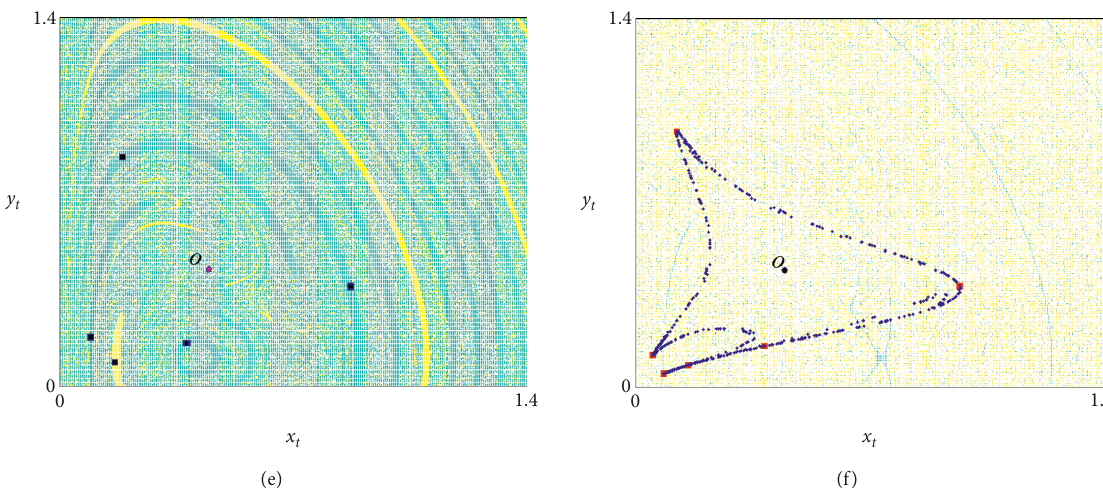
Figure 7: (a) The 2D bifurcation diagram in the ( k, c ) − plane at a � 1 showing different period cycles with different colors. (b) Bifurcation diagram on varying the parameter of memory k at a � 1 and c � 0 . 15. (c) The basin of attraction of the period-4 cycle at a � 1 , c � 0 . 15 and k � 3 . 44. (d) The basin of attraction of the period-8 cycle at a � 1 , c � 0 . 15 and k � 4 . 3 . (e) The basin of attraction of the period-5 cycle at a � 1 ,c � 0 . 15 and k � 4 . 543. (f) The basin of attraction of the period-6 cycle appearing with a chaotic attractor at a � 1 ,c � 0 . 15 and k � 4 .